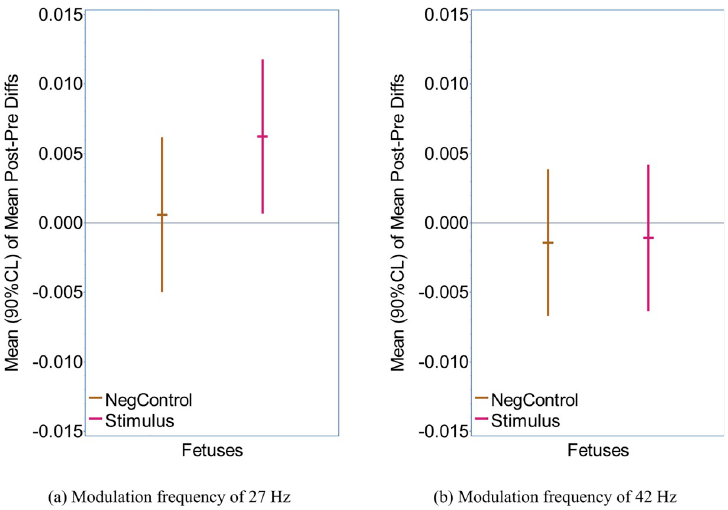
Fig 2. Overall group analysis. Summary of the statistical group analysis of all recordings using a MF of a) 27 Hz, b) 42 Hz. The mean of the post-trigger minus pre-trigger differences of phase coherence is considered for the sensors within a 10-cm radius to the head coil. The error bars represent 90% confidence intervals. For each MF, stimulation recordings (‘Stimulus’) and control recordings (‘NegControl’) are displayed.